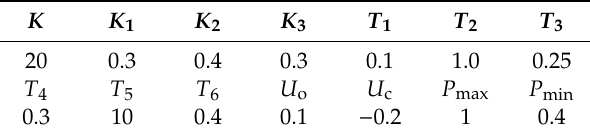
Table 2. Parameters of the IEEEG1 model.